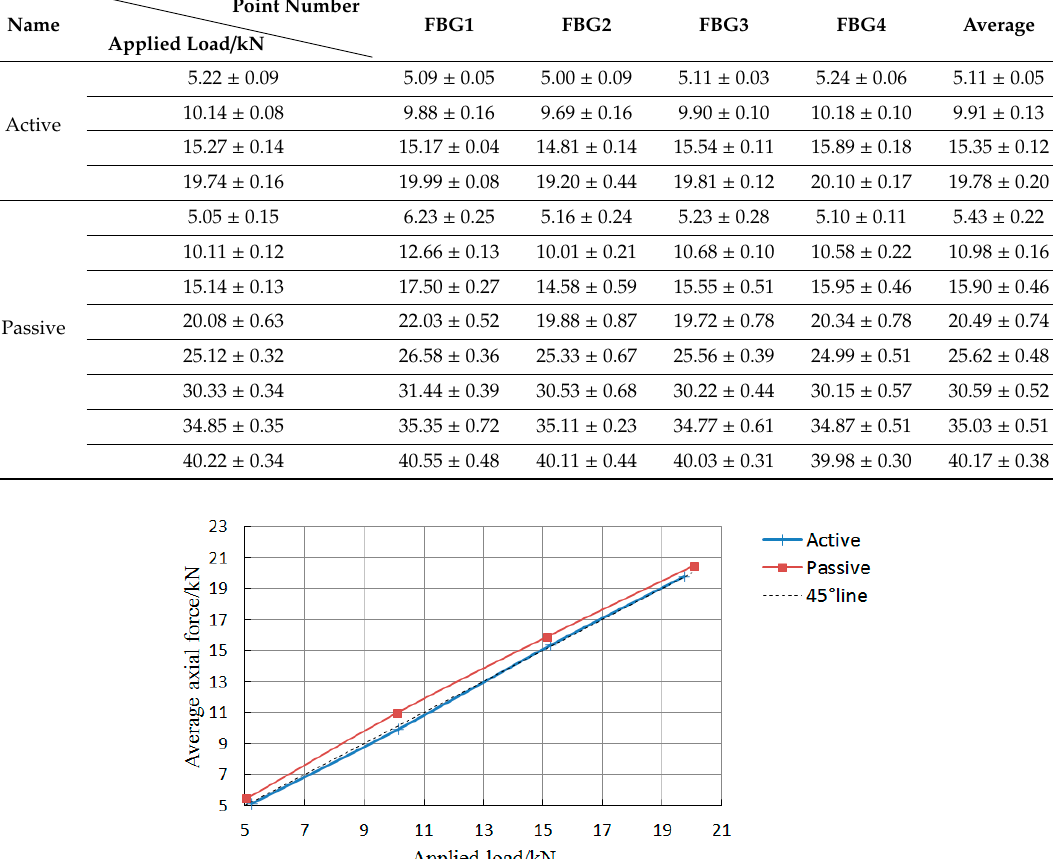
Table 1. The axial force of the measuring point.